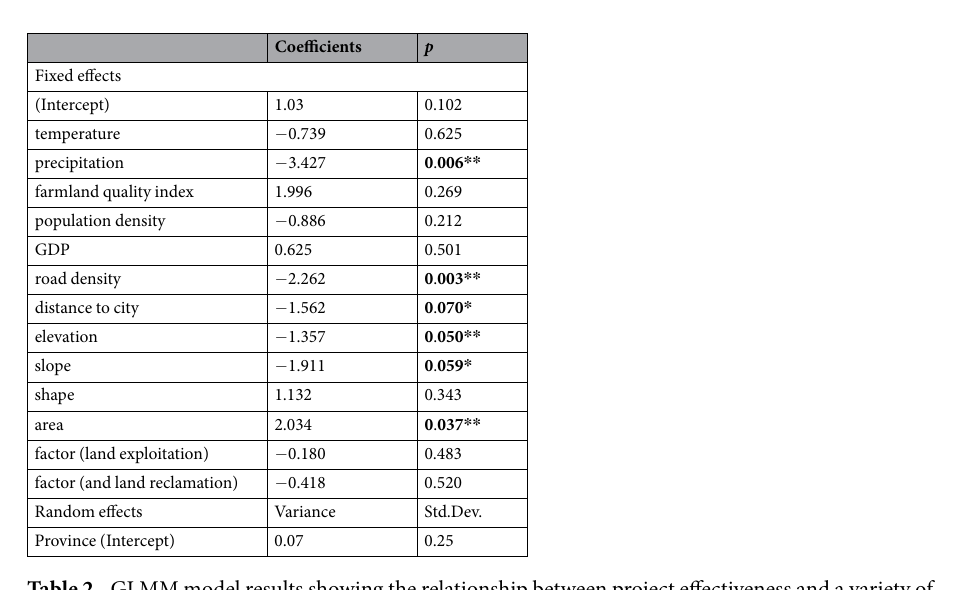
Table 2. GLMM model results showing the relationship between project effectiveness and a variety of biophysical and socio-economic variables. The dependent variable is binary (code 1 = projects showing significant increasing NDVI trends, code 0 = all the remaining